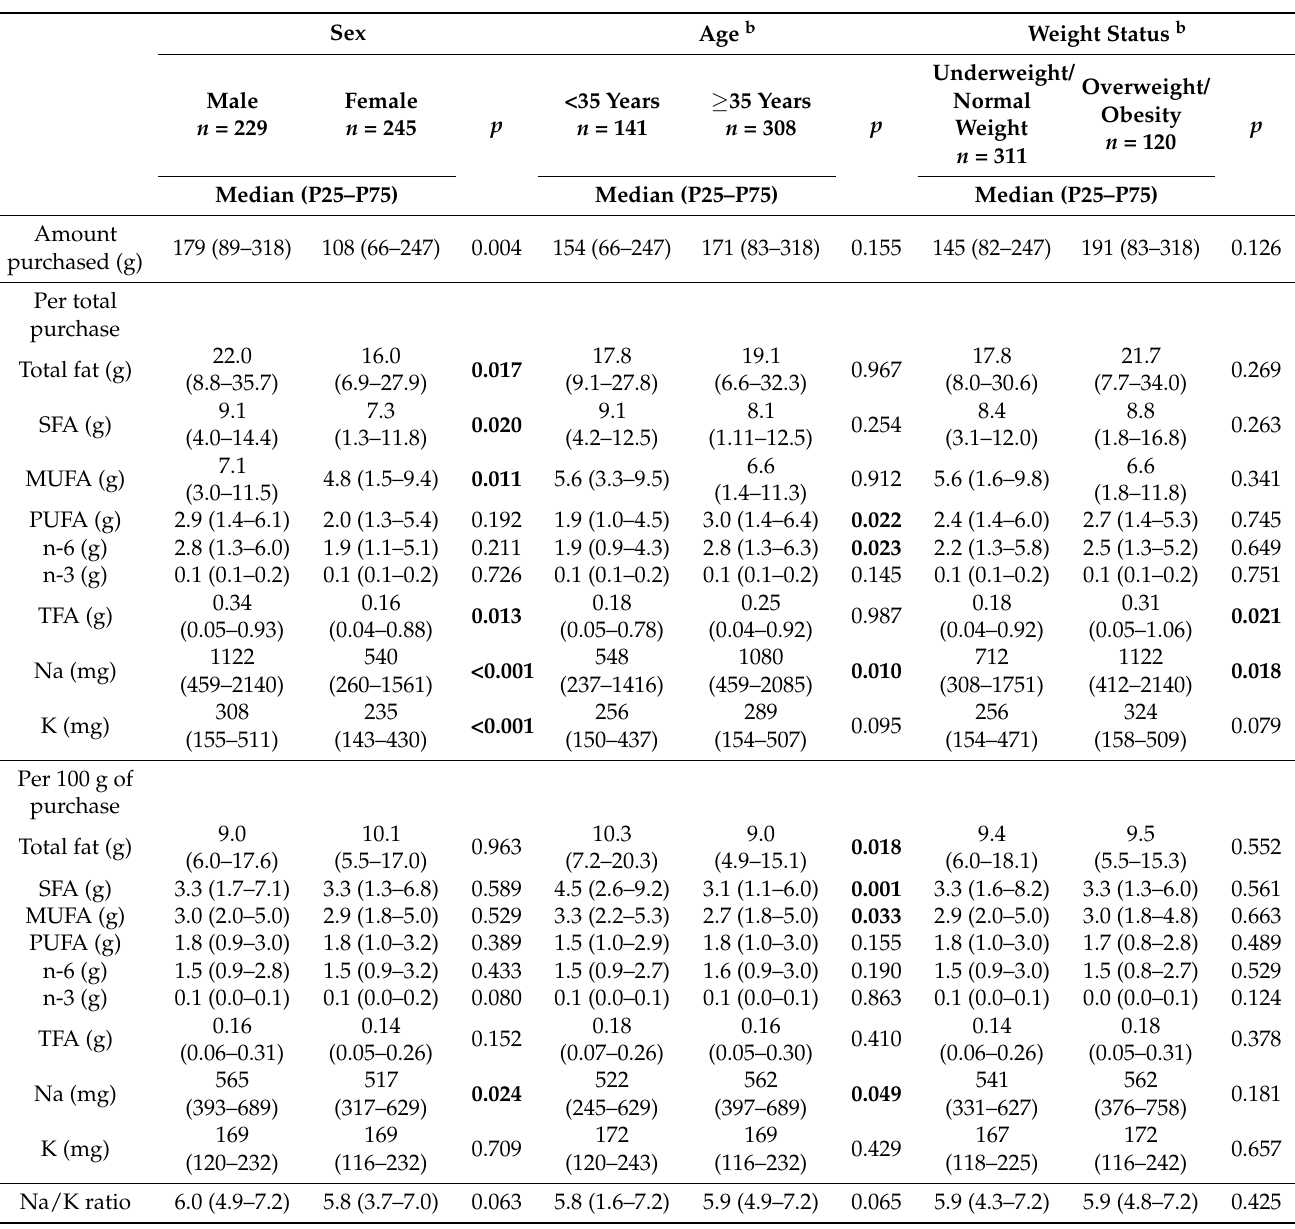
Table 3. Estimated fatty acids, sodium and potassium contents of the purchases made by a sub-sample ( n = 474 a ) of street food and takeaway food customers observed in Sarajevo and Banja Luka, Bosnia and Herzegovina, by sex, age and weight